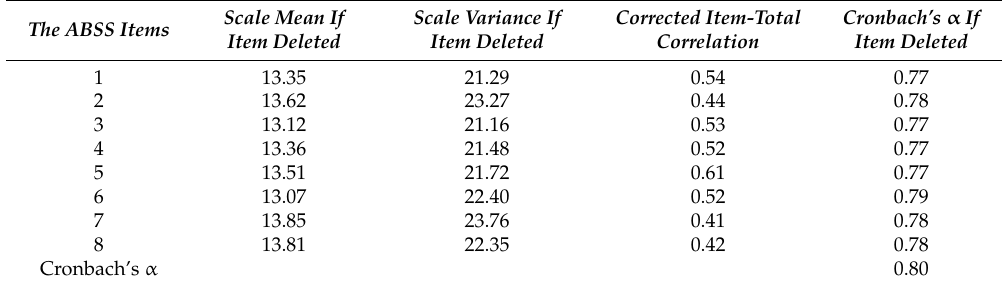
Table 3. Reliability and Item-Total Correlations for the Adventure Behavior Seeking Scale The ABSS